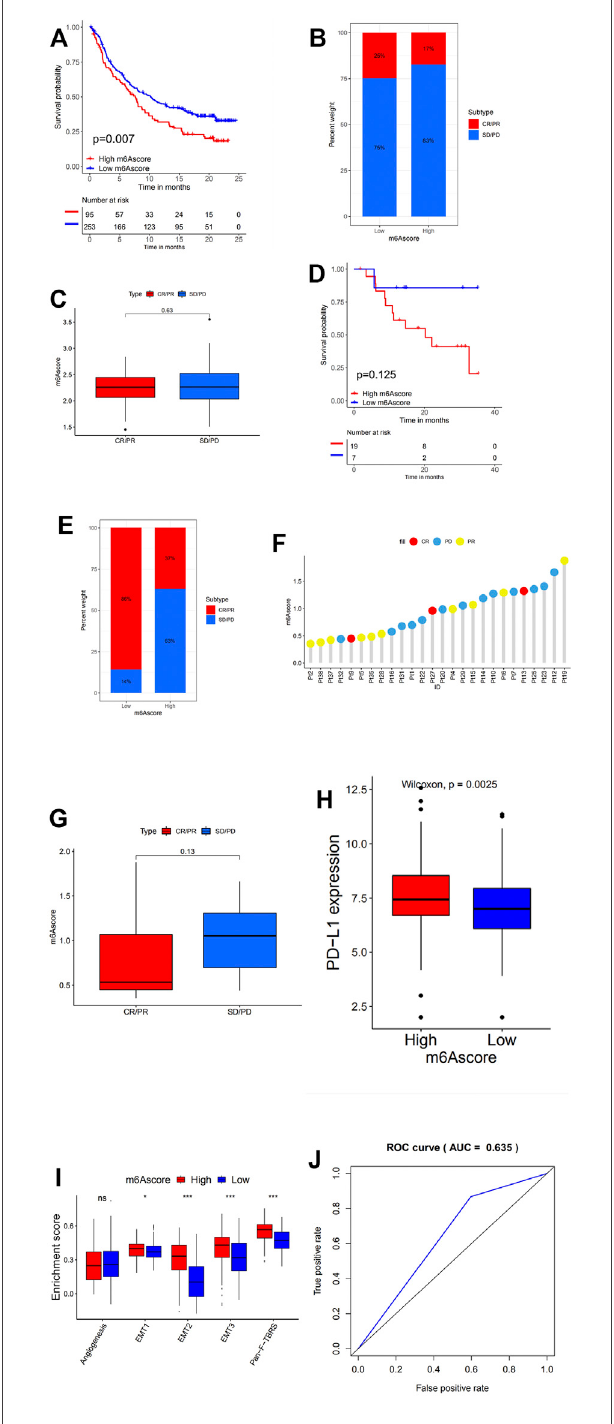
FIGURE 6 | m6A modi fi cation patterns in the role of anti-PD-1/L1 immunotherapy. (A) Survival analyses for low (253 cases) and high (95 cases)